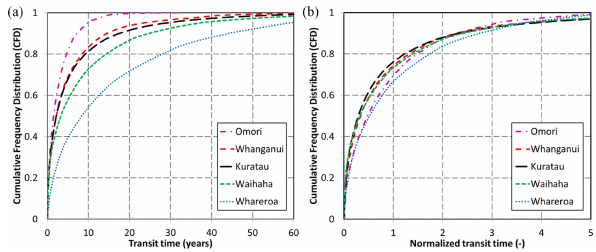
Figure 2. CFDs of transit times for five different watersheds in Lake Taupo region (a) and CFDs with transit times normalized by MTT from Table 1 (b)